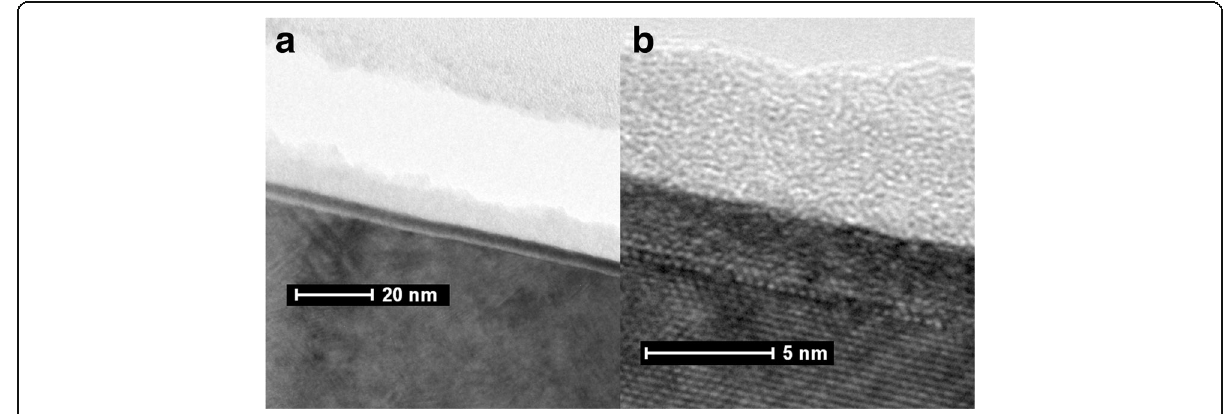
Fig. 1 HR-TEM images of as-grown HfO 2 thin films on InP substrate, with a low magnification and b high